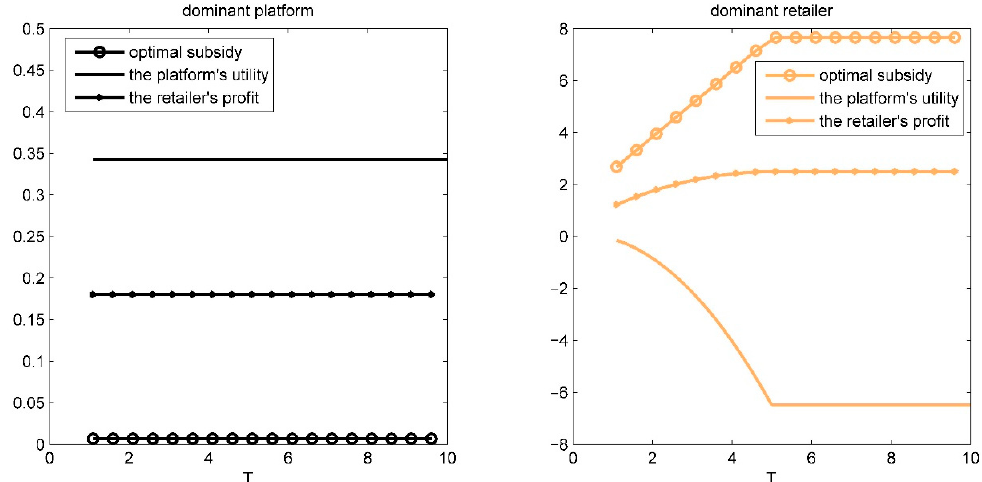
Figure 5. Optimal sales subsidy, the platform’s utility, and the retailer’s profit under different power